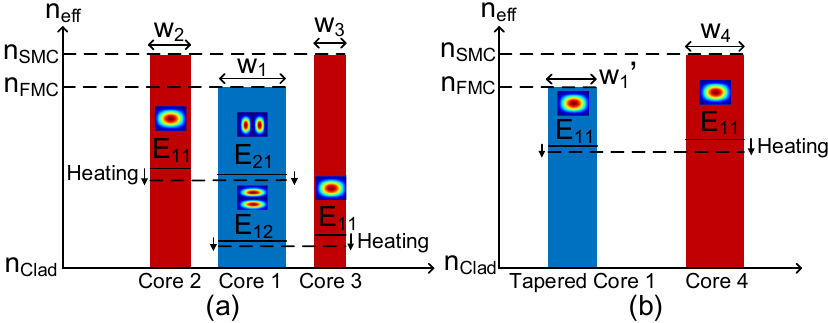
Figure 3. The phase-matching conditions of ( a ) the E 21 and E 12 modes in Core 1 and the E 11 modes in Core 2 and Core 3; ( b ) the E 11 mode in tapered Core 1 and the E 11 mode in Core 4. The GEHs serve to manipulate the coupling of the corresponding DCs. The dimensions of three DCs with GEHs are shown in Figure 4, which are labeled as DC 1, DC 2 and DC 3. The gap distance between the FMC and SMCs is fixed at 3.0 µ m, and the distance between the SMCs and GEHs is fixed at 5.0 µ m. There is a core-to-core lateral offset distance of approximately 6.0 µ m, 4.0 µ m and 4.0 µ m for DC 1, DC 2 and DC 3, respectively. As discussed in Figure 2, the FMC width and height are designed to be 13.0 µ m and 8.0 µ m so that the FMC can support the E 11 , E 21 and E 12 modes. A linear taper is designed in FMC for the DC 3 with the core width tapered to be 8.5 µ m to adjust the effective refractive index of the E 11 mode, where the linear taper induces little loss to the E 21 and E 12 modes. The height of the SMCs is set to be 4.0 µ m and the width of Core 2, Core 3 and Core 4 set to be 5.0 µ m, 3.7 µ m and 8.8 µ m, respectively. The sizes of the SMCs are designed to